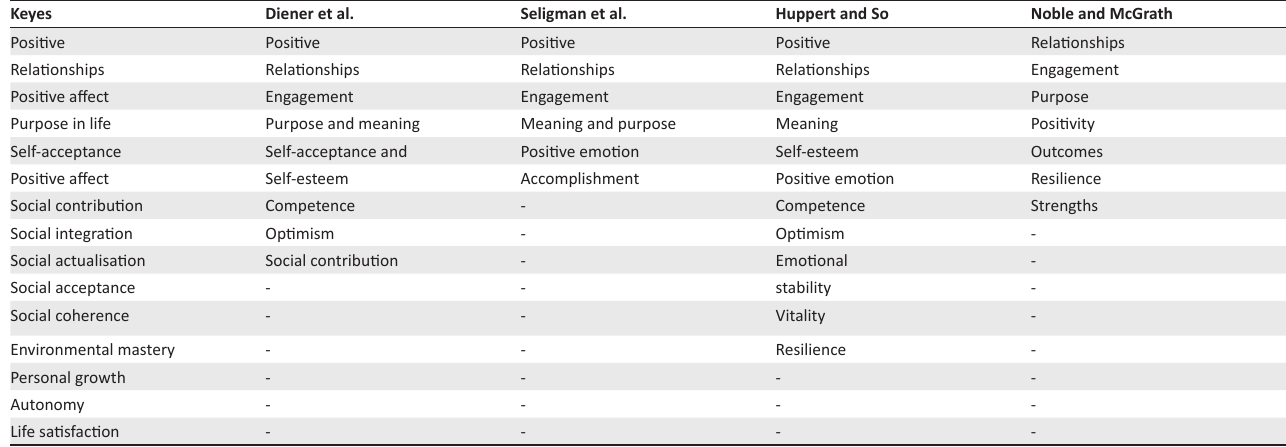
TABLE 1: Five conceptualisations of flourishing. Keyes Diener et al. Seligman et al. Huppert and So Noble and